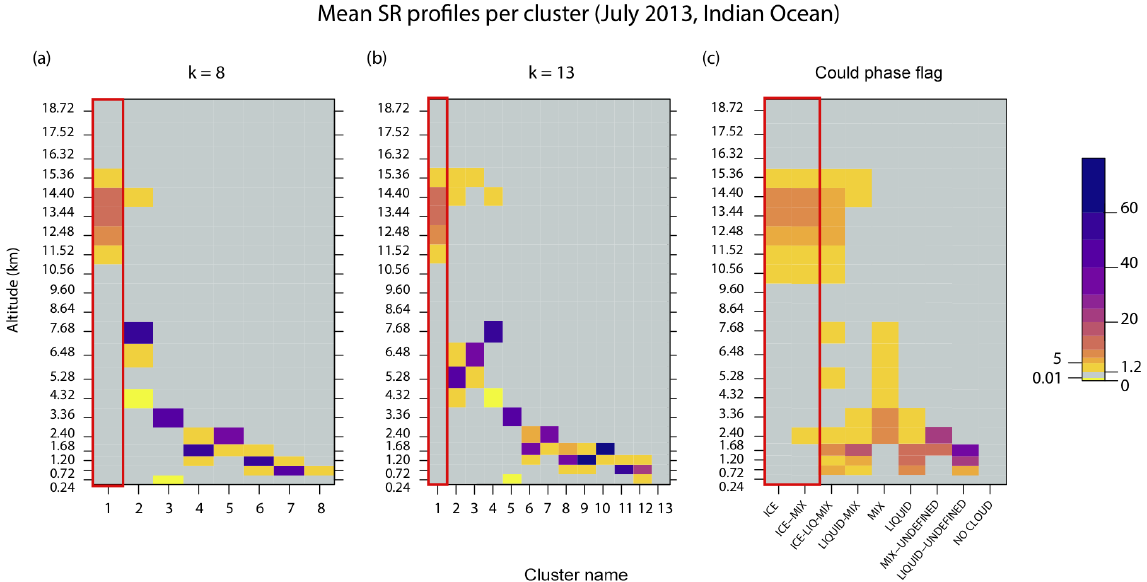
Figure 3. Mean SR profile per cluster for different choices of the clustering method (Indian Ocean, July 2013). (a) : mean SR profile per cluster obtained by a k -means classification setting k = 8. (b) : as (a) but setting k = 13. (c) : mean SR profiles per cluster derived by combining the cloud-phase flags in Cesana and Chepfer (2013). ICE: observations classified as ice only. LIQUID: observations classified as liquid only. MIX: profiles containing SR values derived by averaging observations classified as liquid and observations classified as ice. UNDEFINED: observations for which the cloud-phase flag in Chepfer et al. (2010) is “undefined”, “horizontally oriented”, or “unphysical”. The cluster type is then defined as the combination of these flags. Profiles characterized by other combinations of flags (e.g. FALSE LIQUID, FALSE ICE) correspond to fewer than 250 observations and have been omitted. Selected anvil-type clusters are outlined by a red